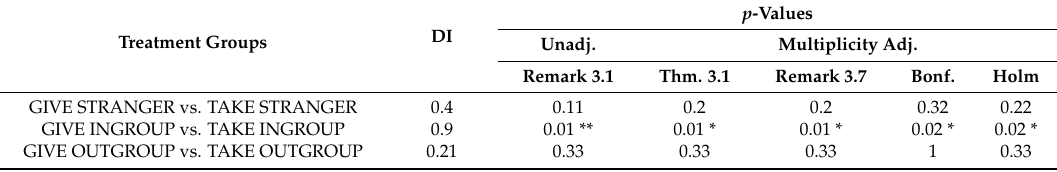
Table A1. Results adjusted p -values by multiple hypothesis testing according to List et al.